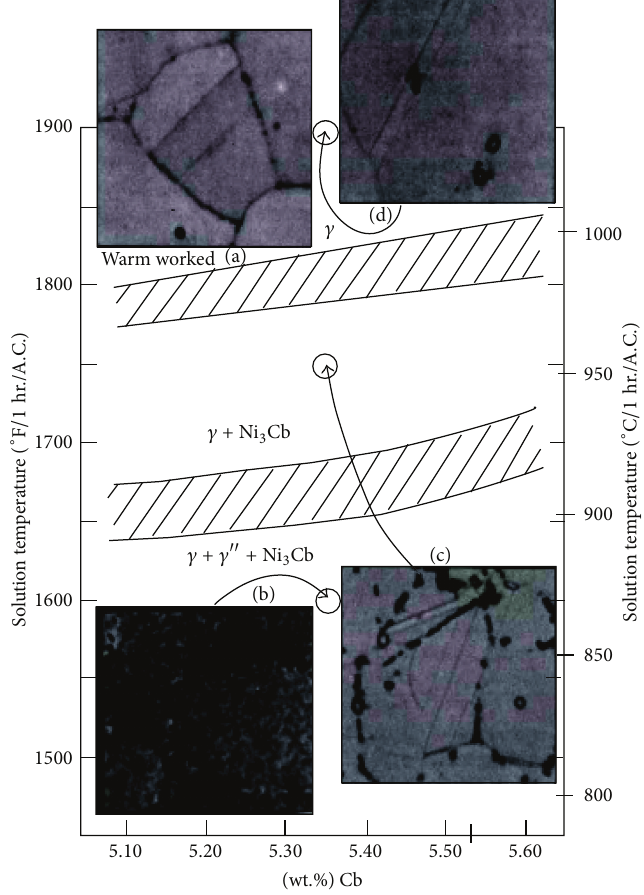
Figure 2: Influences of temperature change on the material structure